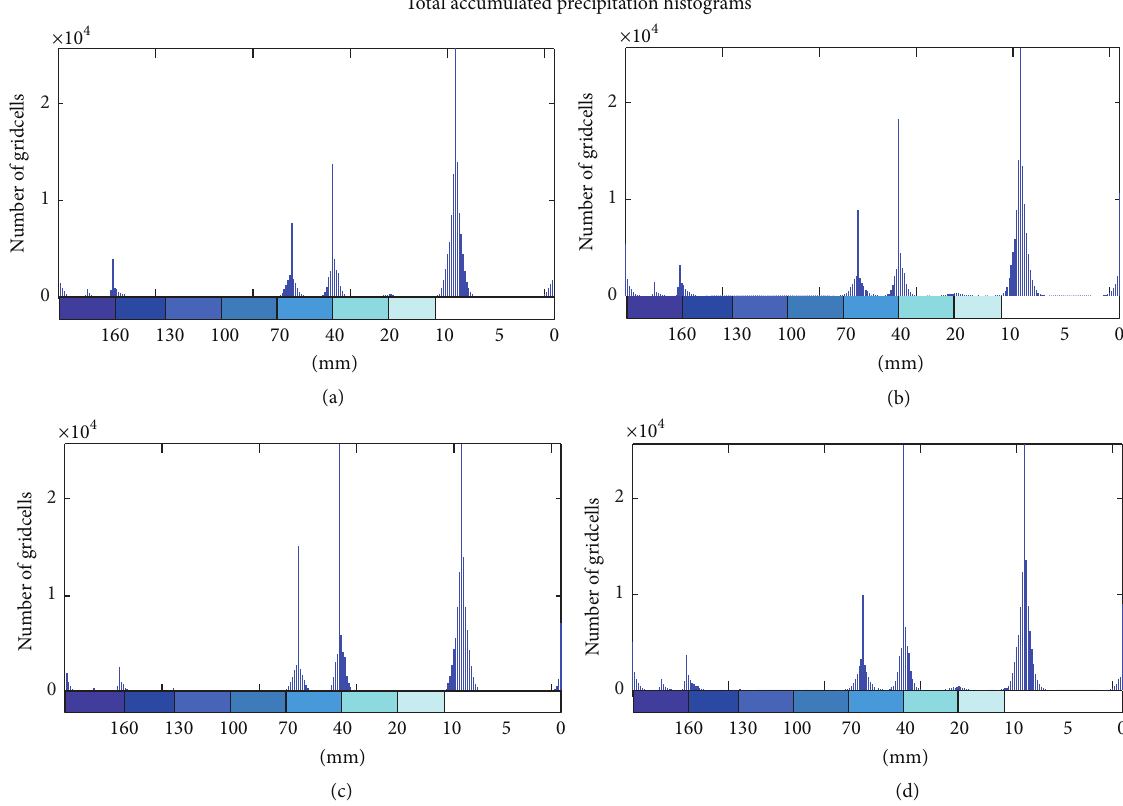
Figure 14: Number of grid cells per accumulated precipitation total for (a) Run 1, (b) Run 2, (c) Run 3, and (d) Run